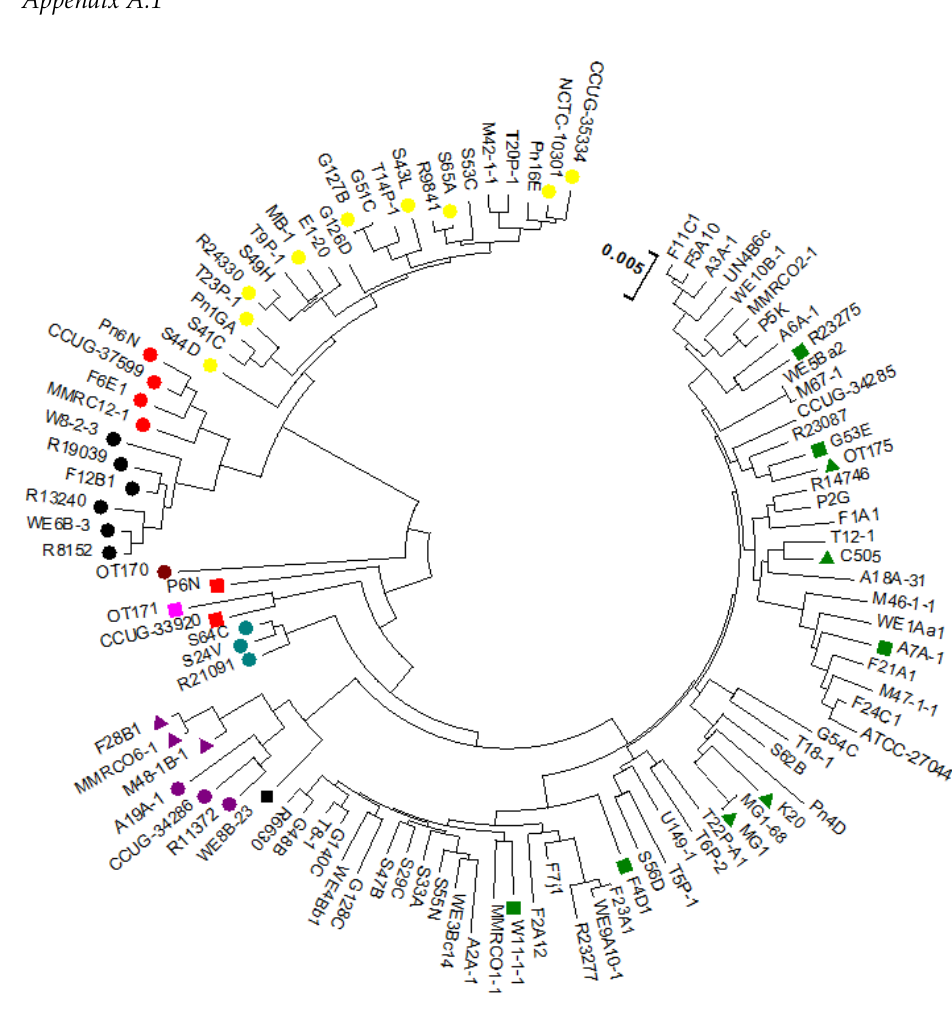
Figure A1. Concatenation of 7 house keeping genes. A. oris